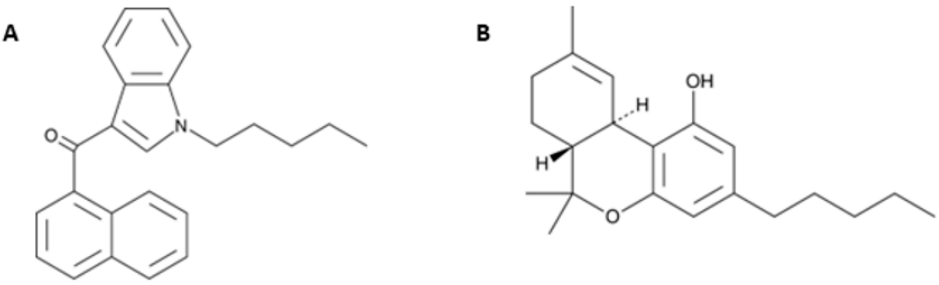
Figure 1. Chemical structures of JWH-018 (1-pentyl-3-(1-naphthoyl)indole; panel ( A ) and ∆ 9 -THC ( ∆ 9 -Tetrahydrocannabinol; panel ( B ) from the Cayman Chemical website (https://www.caymanchem.com, last access on Tuesday 30 November 2021, at 3.30 pm).